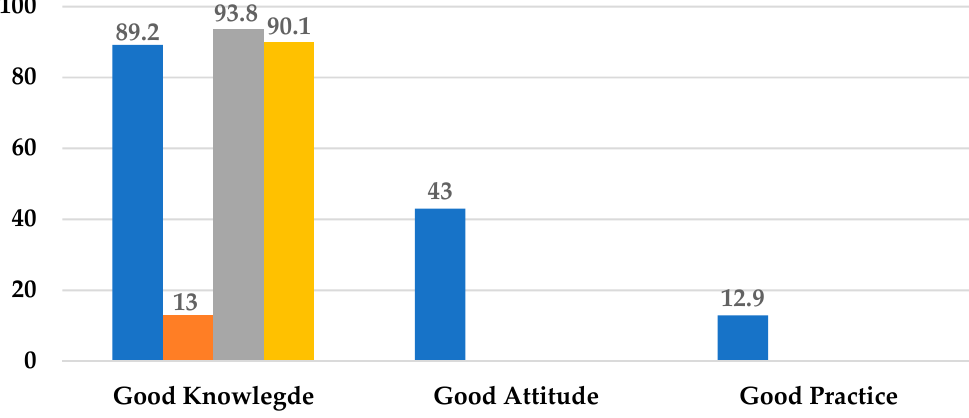
Figure 1. Good KAP about hepatitis B .